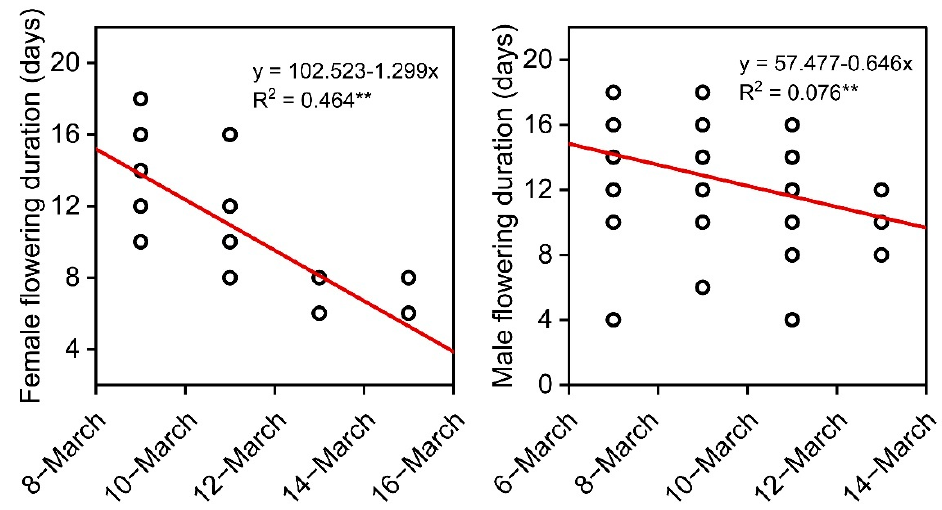
Figure 3. Linear regression between the initial stage and male and female flower duration. Note: ** means a significant difference at the level of 0.01.